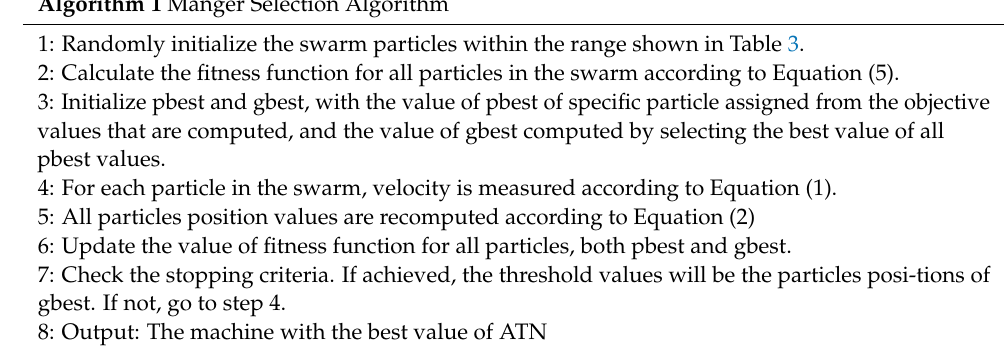
Algorithm 1 Manger Selection Algorithm